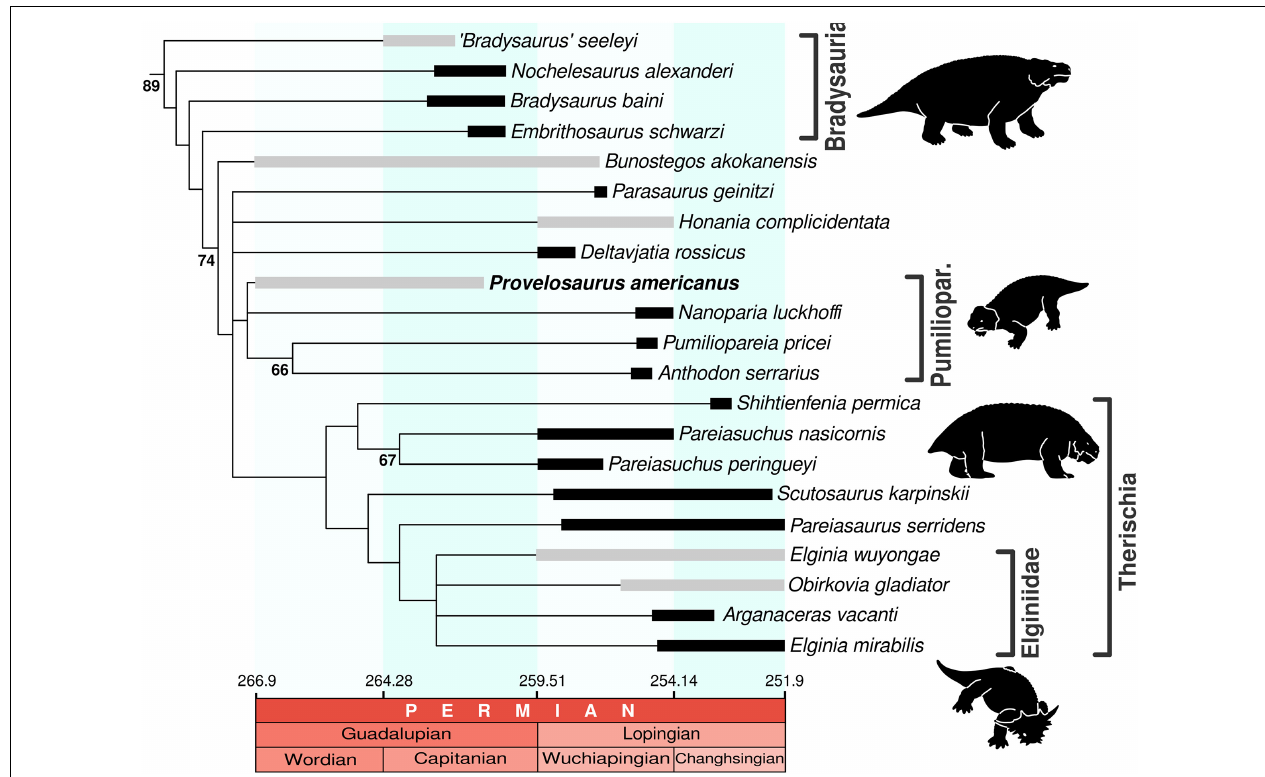
FIGURE 14 | Stratigraphically calibrated relationships of Pareiasauria. Majority rule consensus of 200 MPT (tree score: 270) excluding Sanchuansaurus pygmaeus . Numbers behind nodes represent symmetric resampling values above 50% (calculated from 5000 replicates, p = 33). Pareiasaur occurrences/ranges based on Jalil and Janvier (2005), Tsuji and Müller (2008), Liu et al. (2014), Benton (2016), Olroyd and Sidor (2017), Sennikov and Golubev (2017), Liu and Bever (2018), Day and Rubidge (2020), Day and Smith (2020), Schneider et al. (2020), Smith (2020), Smith et al. (2020), and Viglietti (2020). Dates after Cohen et al. (2021).